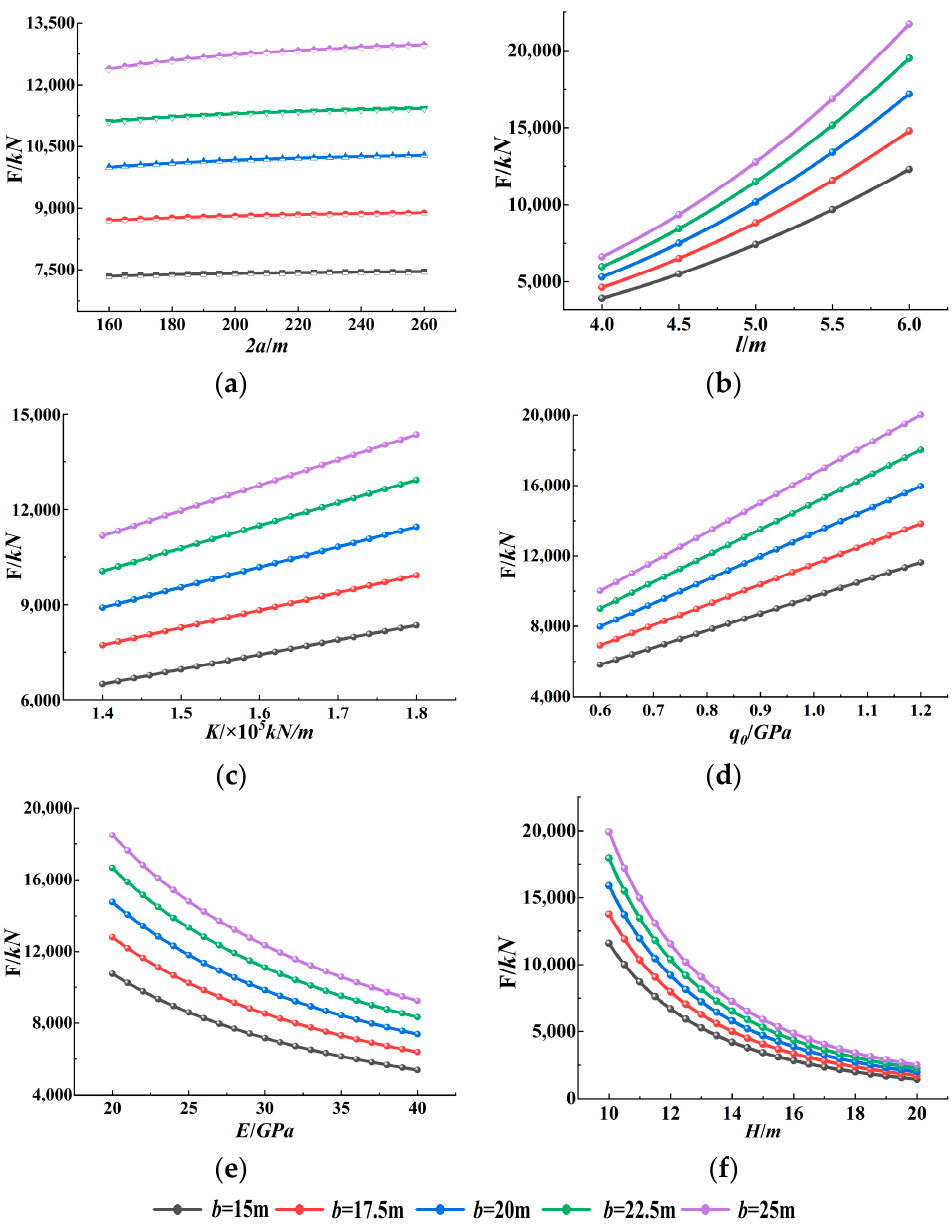
Figure 8. Analysis of influencing factors of support resistance F : ( a ) Relationship curve of F and 2 a ; ( b ) Relationship curve of F and l ; ( c ) Relationship curve of F and K ; ( d ) Relationship curve of F and q 0 ; ( e ) Relationship curve of F and E ; and ( f ) Relationship curve of F and H . Hydraulic brace working resistance is affected by the directly covered thick hard